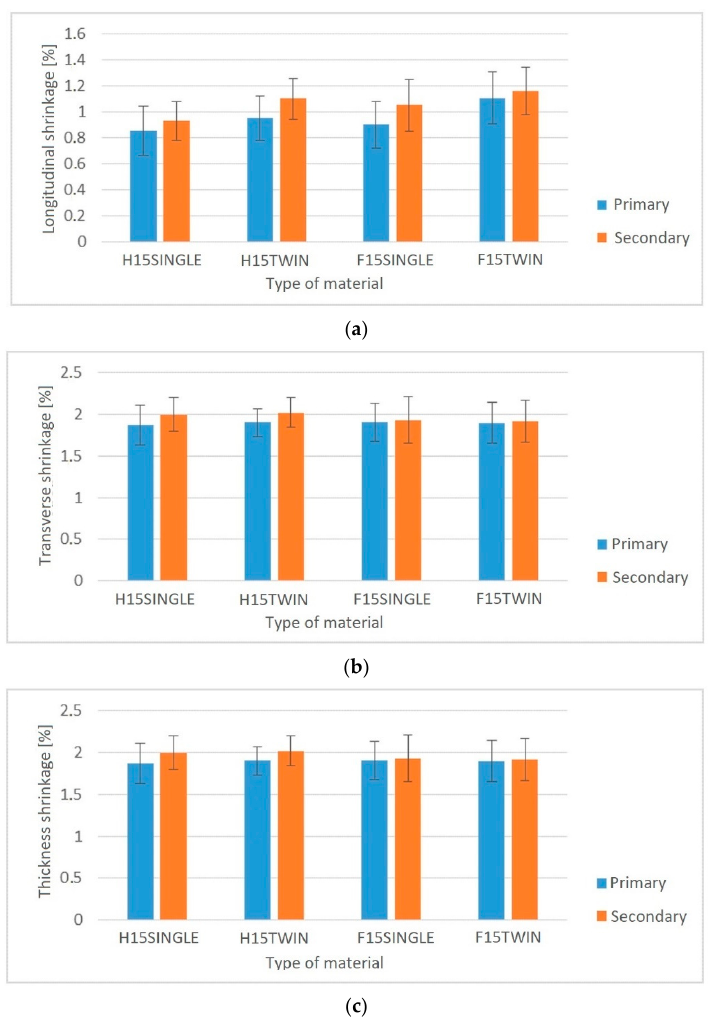
Figure 10. Primary and secondary shrinkage of injection moldings: ( a ) longitudinal shrinkage, ( b ) transverse shrinkage, ( c ) thickness shrinkage, for biocomposites produced by single- and twin- screw extrusion.